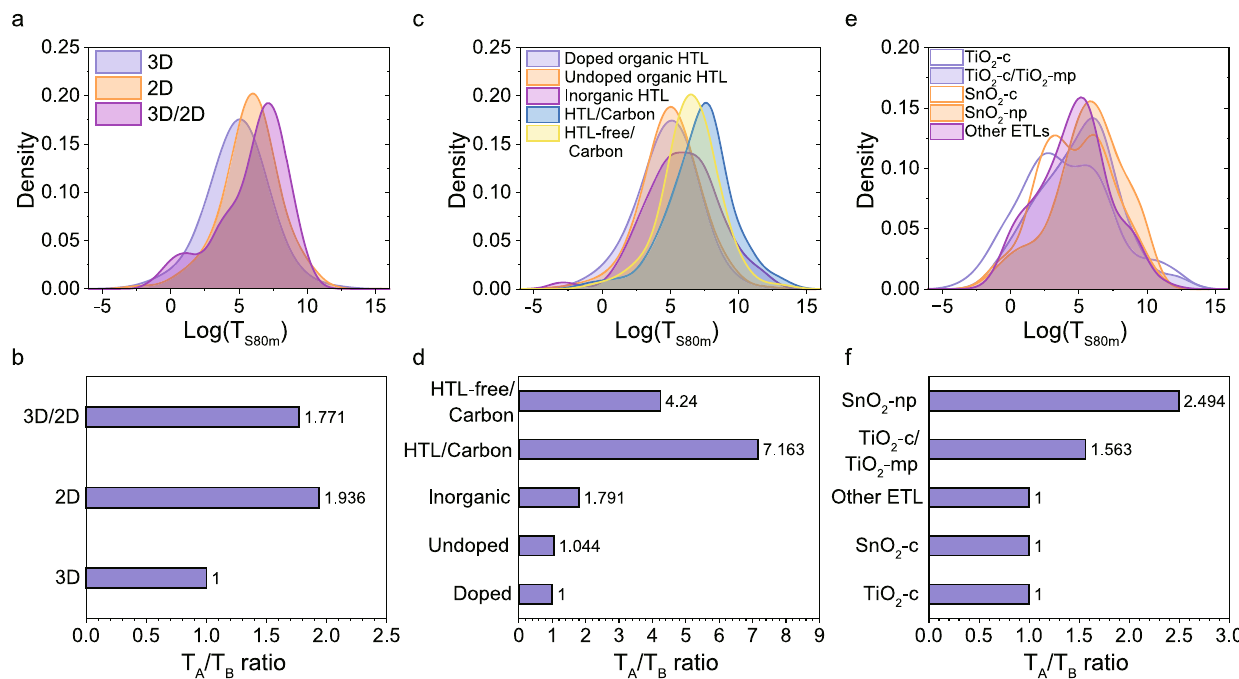
Fig. 4 | The relationship between device stability and different functional layers. The kernel density estimation of the log( T S80m ) values and the bar chart of T T A / B ratios for unencapsulated devices with a , b different perovskite absorbers (3D, i.e., three-dimensional perovskites; 2D, i.e., two-dimensional perovskites; 3D/ 2D, i.e., three-dimensional perovskites with two-dimensional perovskite capping